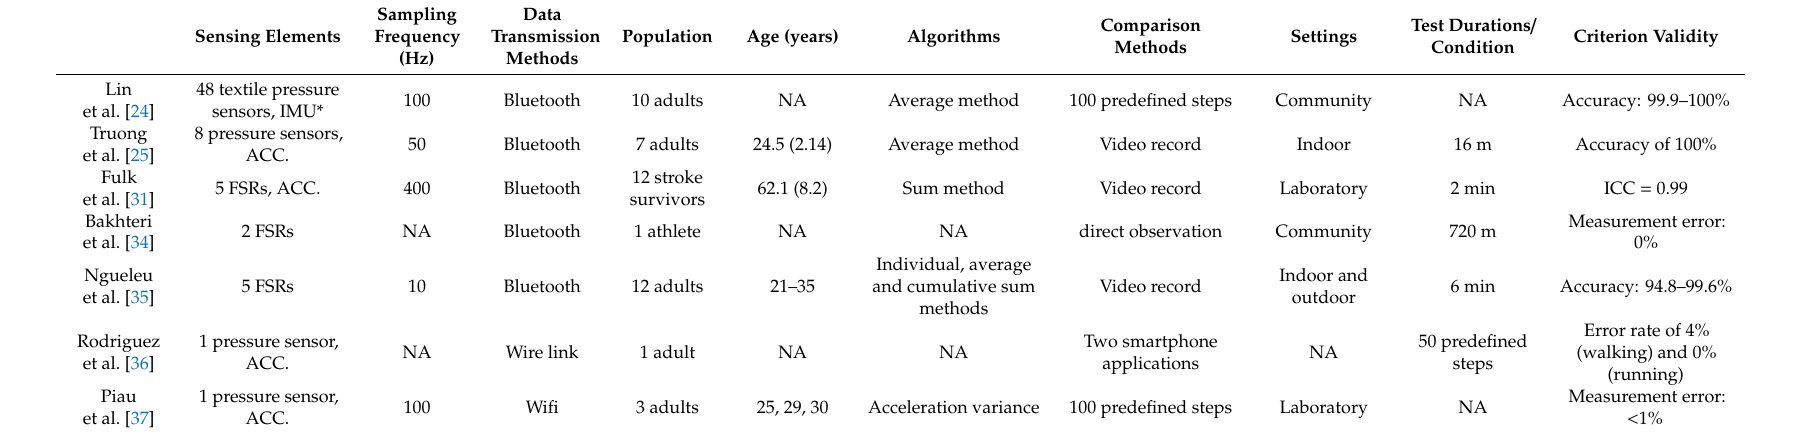
Table 3. Description of technical features and criterion validity of insoles for step